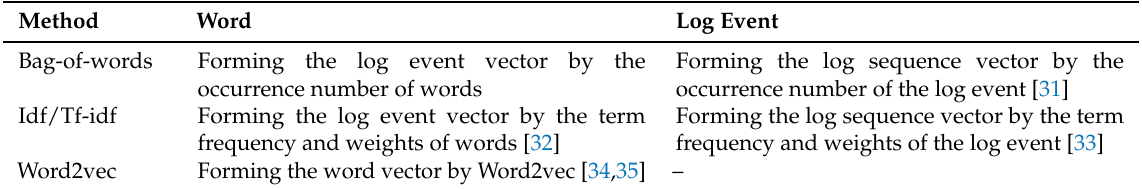
Table 1. Feature Extraction based on